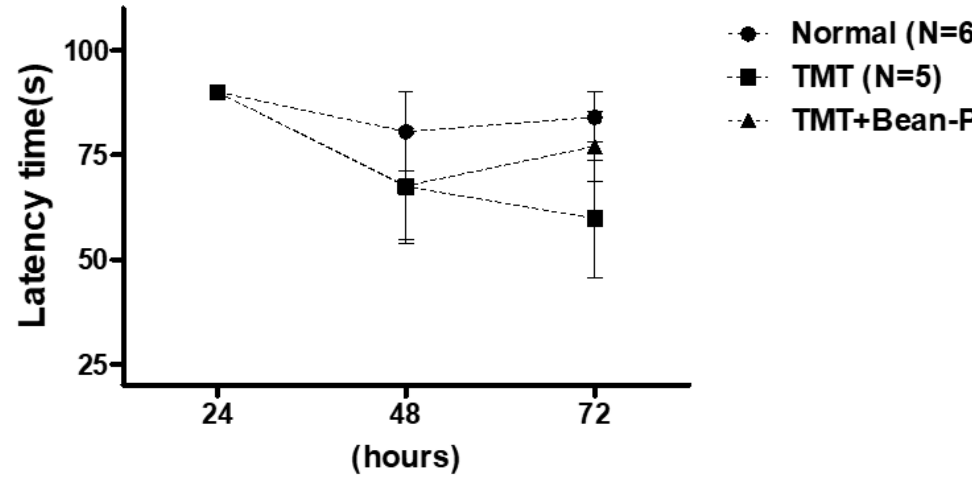
Figure 2. Effect of Bean-PS on escape latency into the dark phase of the retention test during the passive avoidance task. Each value is expressed ± S.E.M. Normal group ( N = 6); TMT group ( N = 5); TMT-Bean-PS ( N = 5).